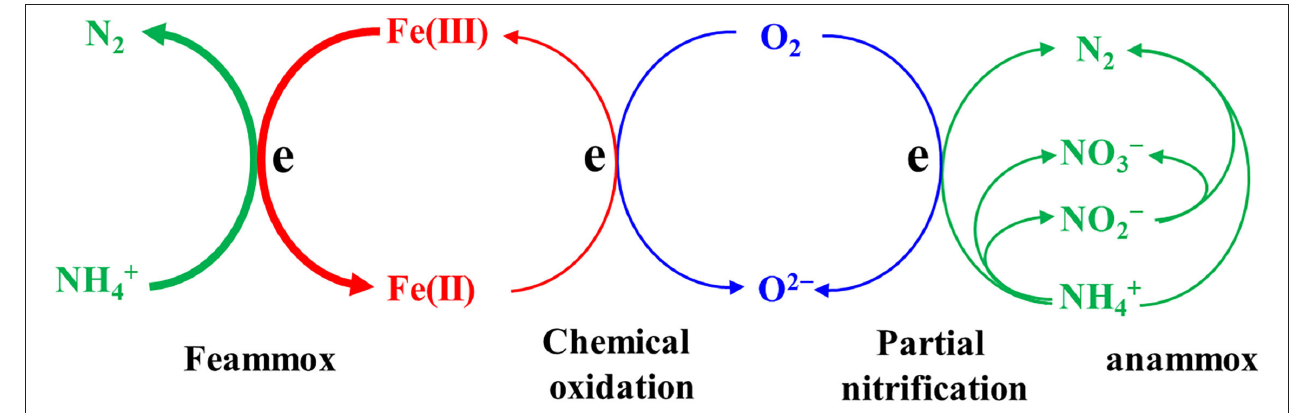
FIGURE 6 | Pathways of nitrogen removal in this study.